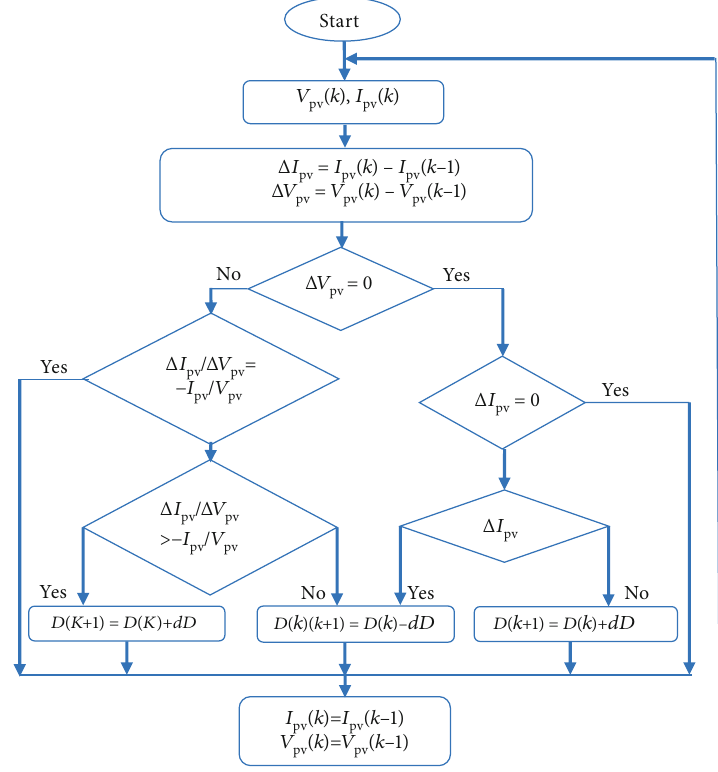
Figure 6: Flowchart of the basic INC algorithm.